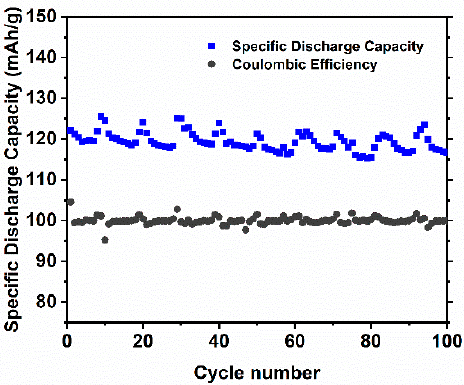
Figure A2. Additional cycle performance of NCAT4 cells.